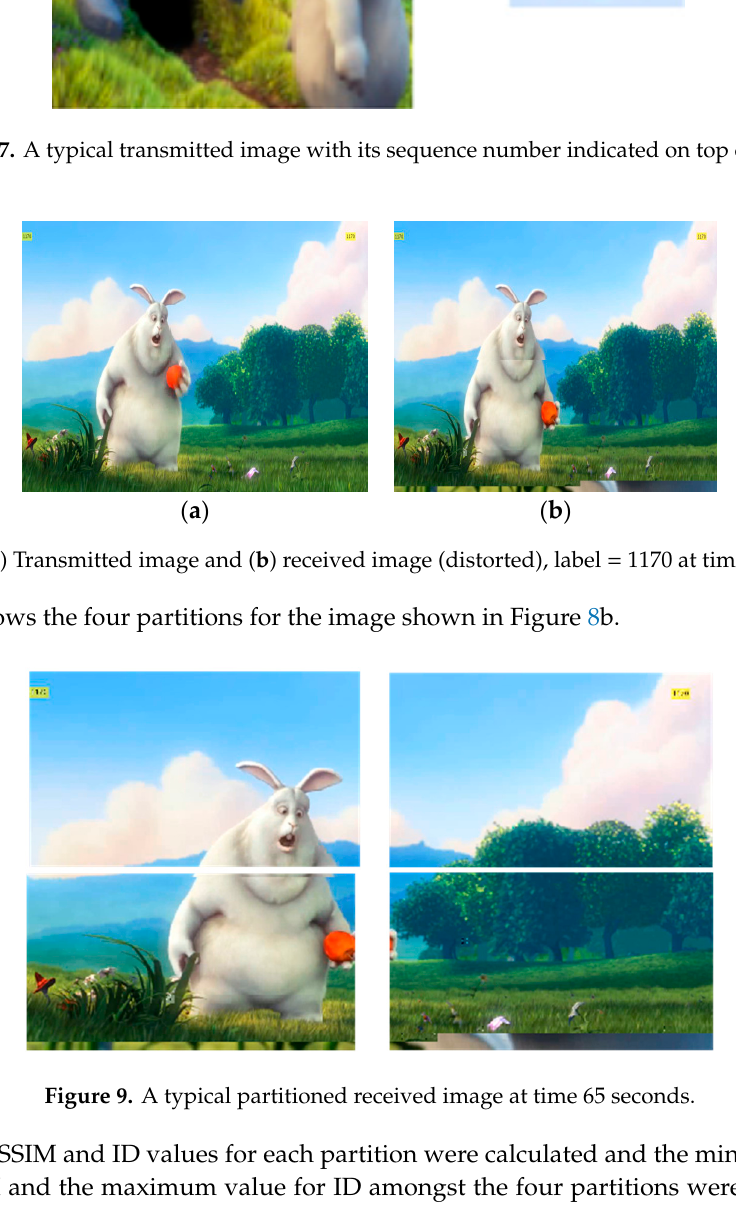
Figure 9. A typical partitioned received image at time 65 seconds.